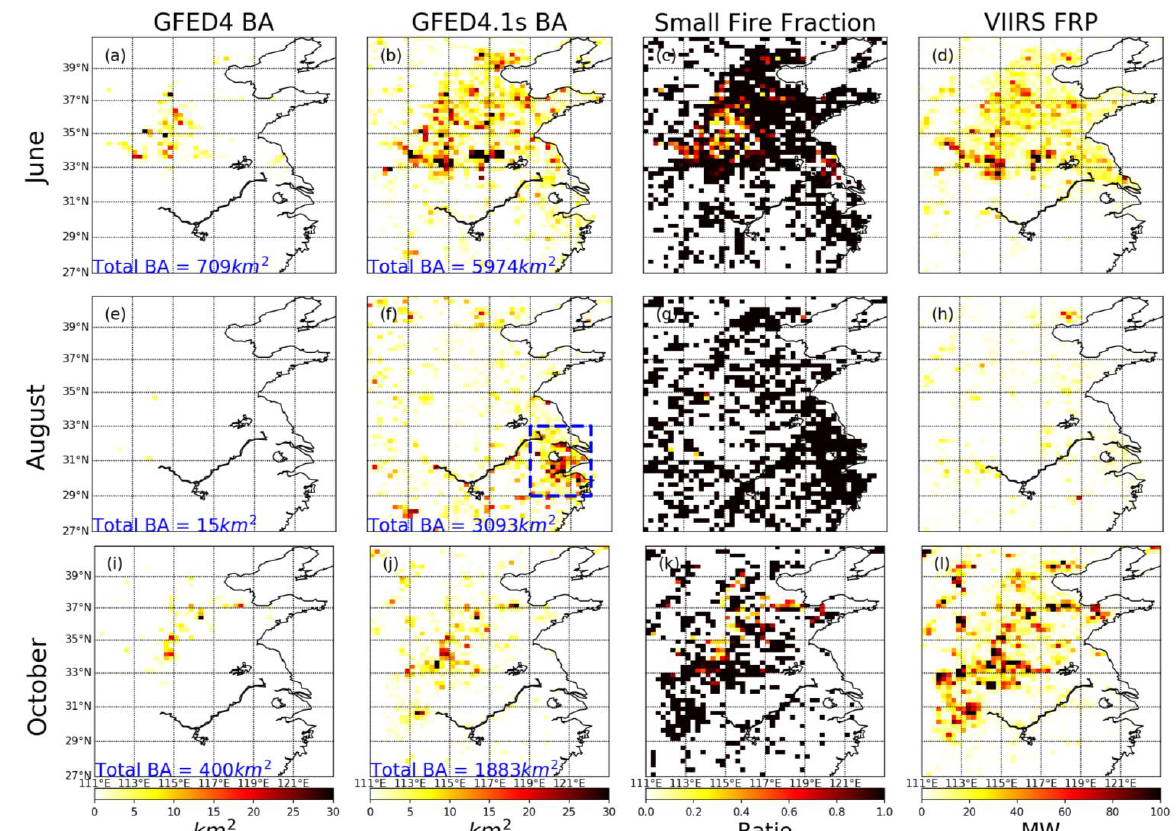
Figure 1. Spatial mapping (0.25 ◦ ) of the fire affected regions for 2015 in eastern China in June ( a – d ), August ( e – h ) and October ( i – l ). (1st column) burned area (BA) reported by GFED4, which uses the MODIS MCD64A1 BA product as its BA metric for all years after the early 2000’s. (2nd column) BA reported by the most recent GFED4.1s inventory, which increases the basic MCD64A1 measured BA via an adaptation of the ‘small fire boosting’ approach developed by [11] (which is primarily driven by MODIS AF detections). (3rd column) Fraction of BA reported by GFED4.1s that comes from the SFB methodology of [11], and (4th column) the fire radiative power (FRP) reported in the same area by the VIIRS-IM product of Zhang et al. [17] that is sensitive to both small and large fires. June and October are the periods of most intensive agricultural burning in this region of eastern China [17,21], which makes the ‘strongly boosted’ BA seen in August in GFED4.1s (highlighted with the blue dashed rectangle in ( f )) seem potentially erroneous, and at odds with a lack of fire activity reported by the VIIRS-IM product for the same month ( h